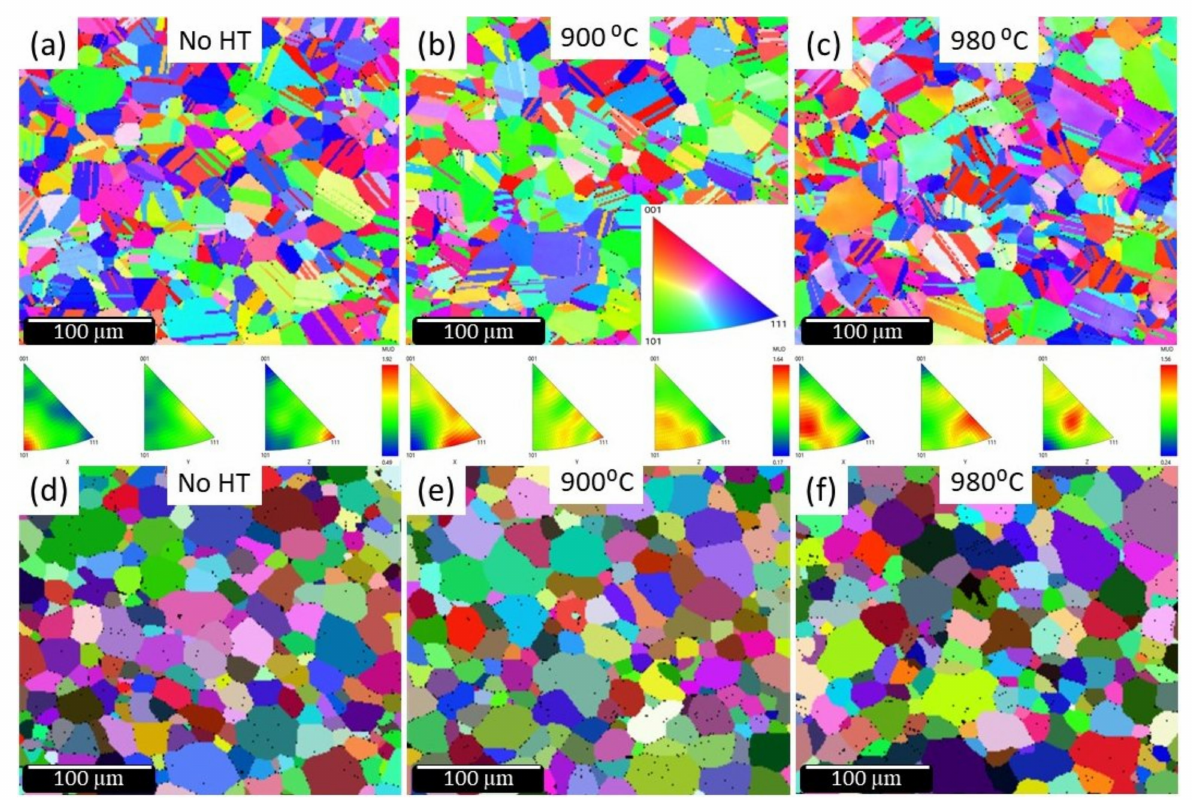
Figure 8. Texture map for specimens that underwent ( a ) no HT, ( b ) 900 ◦ C, and ( c ) 980 ◦ C. Although a texture variation was observed among the three heat treatments, the overall texturing was weak. ( d ) No HT, ( e ) 900 ◦ C, and ( f ) 980 ◦ C specimen grain structure after being corrected on the AZtec software to remove twins and more accurately measure grain